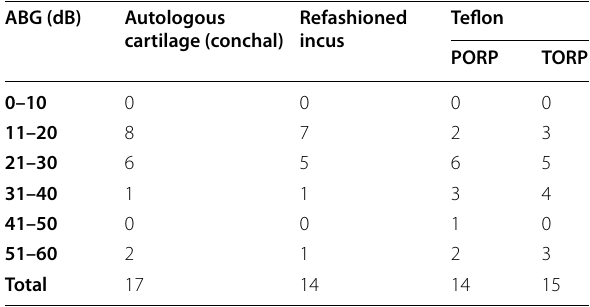
Table 2 Postoperative air–bone gap (ABG) at 3 months with different ossiculoplasty materials ( n